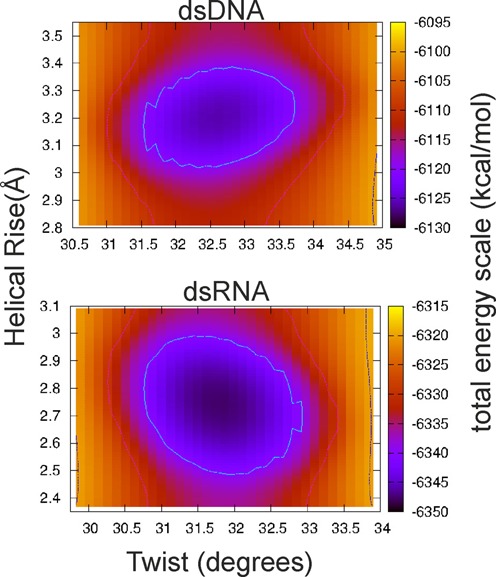
Histogram of the calculated total energy (using an implicit solvent model, see Methods) of sampled dsDNA and dsRNA conformations (in unrestraint simulations) versus mean helical twist and mean helical rise. The color-coded total energy is shown for the range of ∼35 kcal·mol-1 with respect to the lowest energy (same color for larger energies).